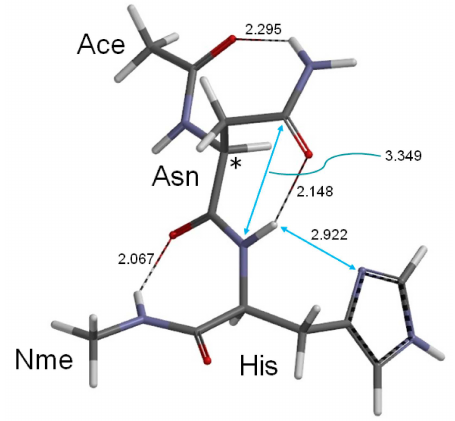
Figure 3. The optimized geometry of the reactant R (model compound, Figure 1) ( ϕ N = ´ 167 ˝ , ˝ , χ ˝ , ϕ ˝ , ψ ˝ , χ ˝ ). Relevant interatomic distances are ψ N = ´ 178 1N = ´ 138 H = ´ 88 H = 64 1H = ´ 73 shown in Å. The α carbon of Asn is indicated by an